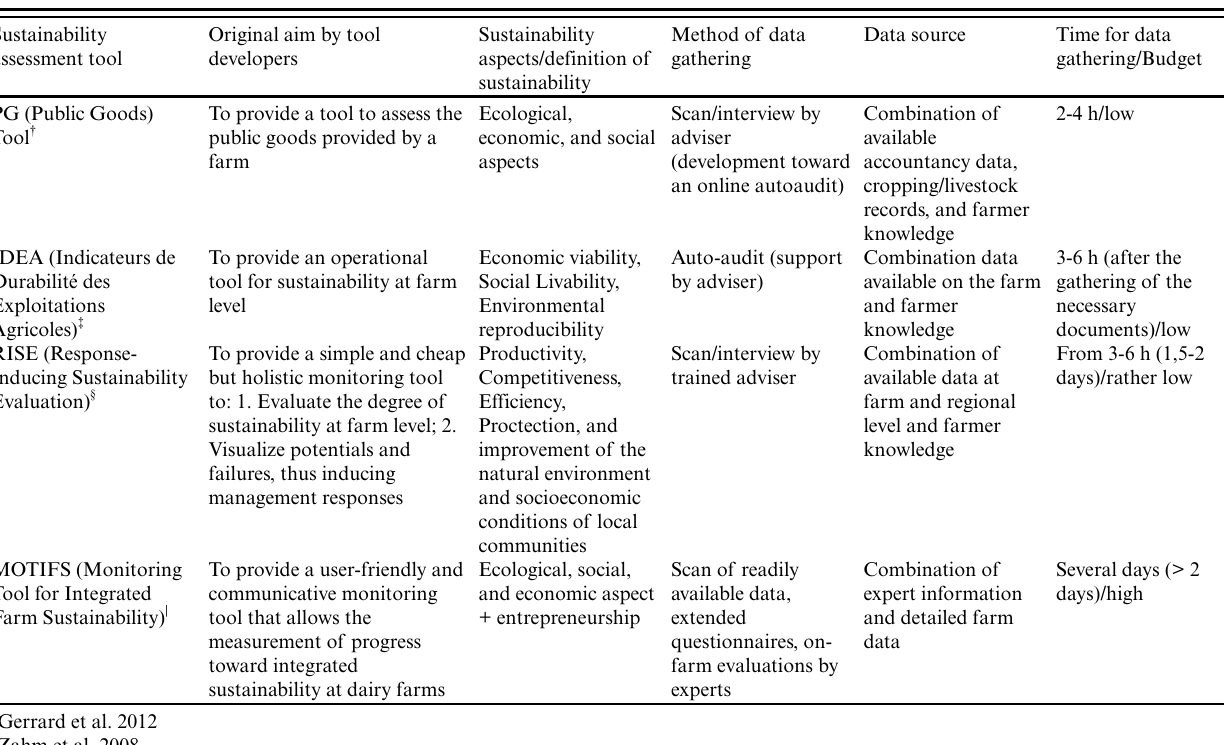
Table 1 . Examples of assessments at the farm